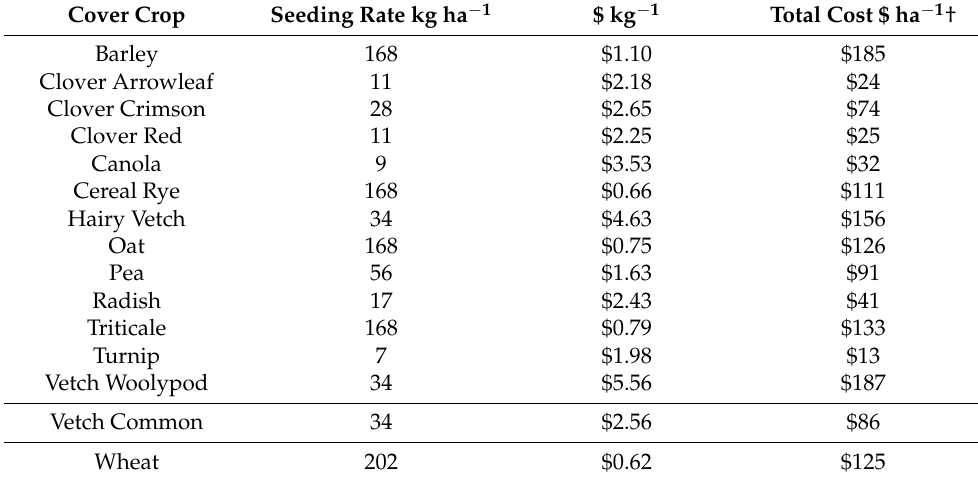
Table 1. Seeding rate and cost of cover